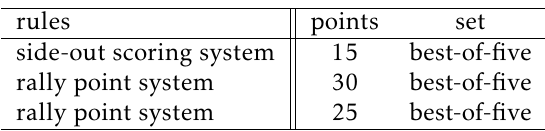
Table 5. Three rule variants of Volleyball